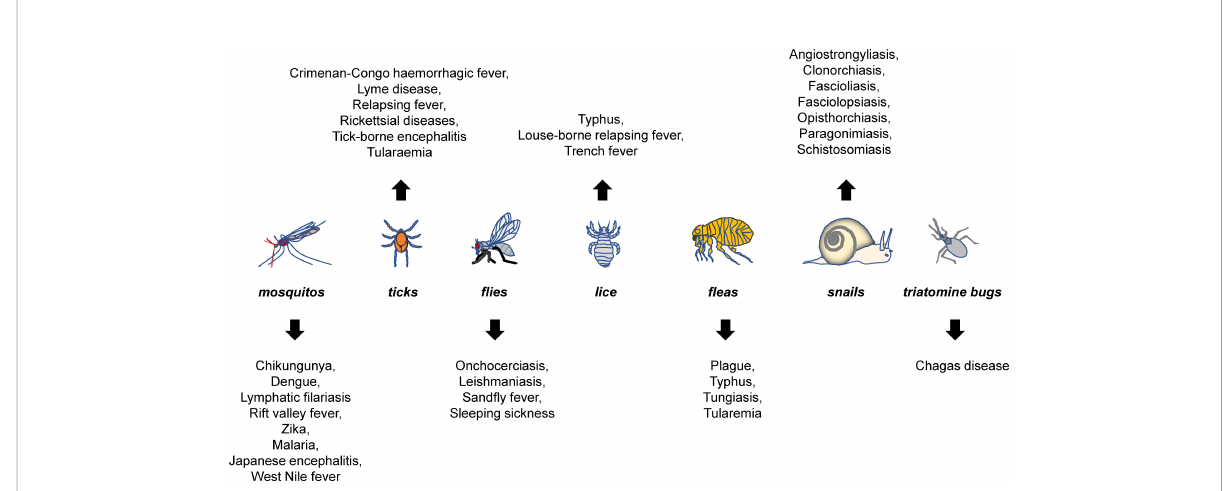
FIGURE 1 Major vector-borne diseases and their vectors. Mosquitos, ticks, fl eas, fl ies, lice, snails, and triatomine bugs are best-characterized vectors that can carry pathogens for a variety of diseases. The listed are representative rather than a complete list of major vector-borne diseases that are known to be transmitted by each of the